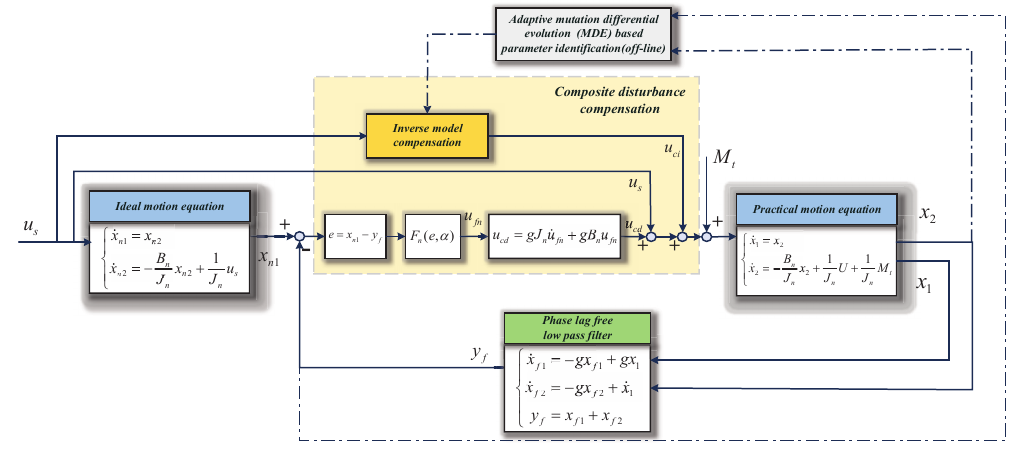
Figure 5. Control strategy of the composite disturbance compensation method in the inner